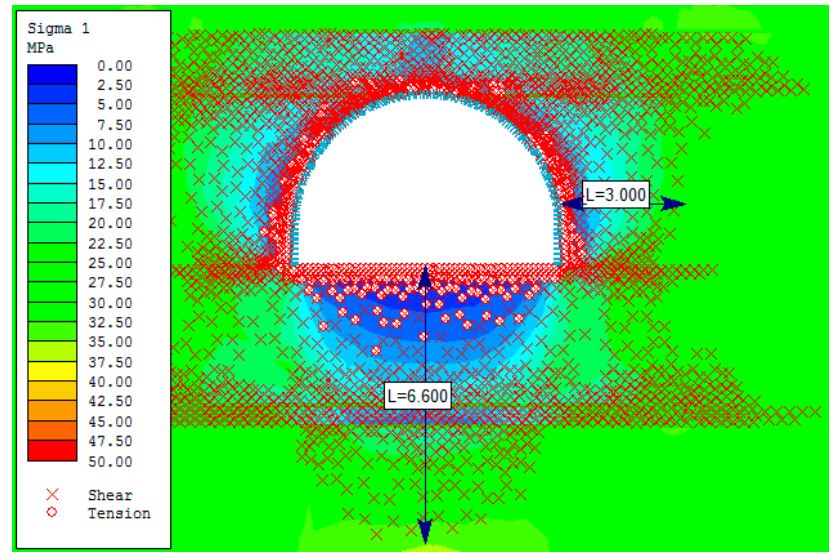
Figure 12. Model no. 6 elasto-plastic with 20% post-failure strength weakening of the rock mass—map of stress distribution around the opening.